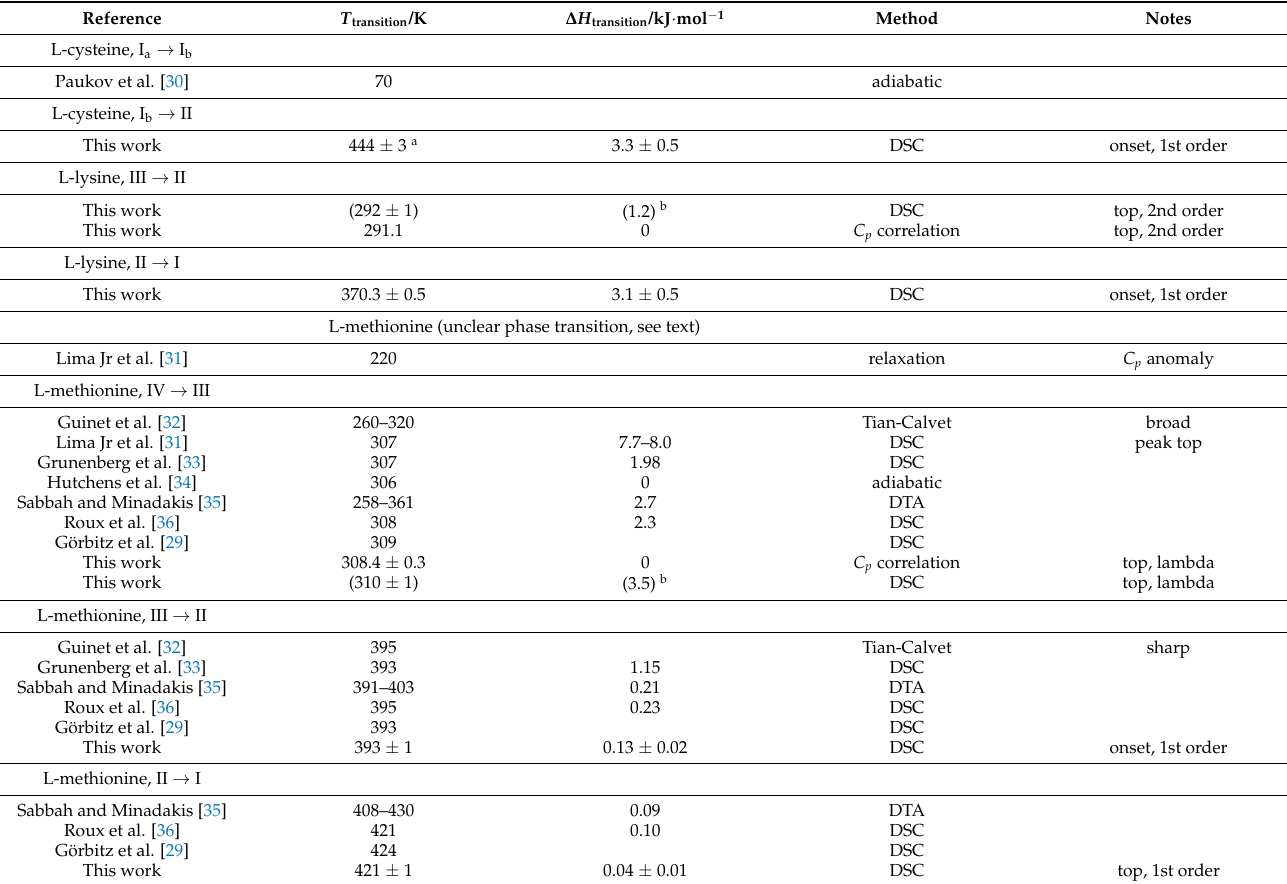
Table 3. Phase Transitions of L-Cysteine, L-Lysine, and